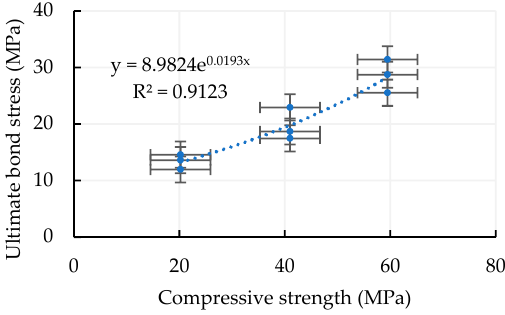
Figure 11. The proposed univariate regression prediction model of bond strength.